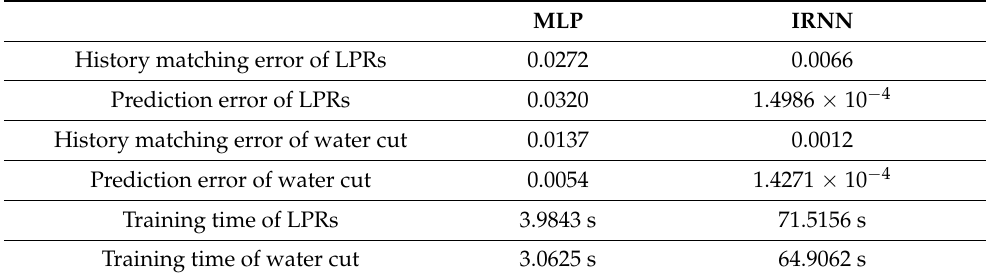
Table 4. The computation error (MSE) and time (seconds) of both MLP and IRNN of Olympus model.